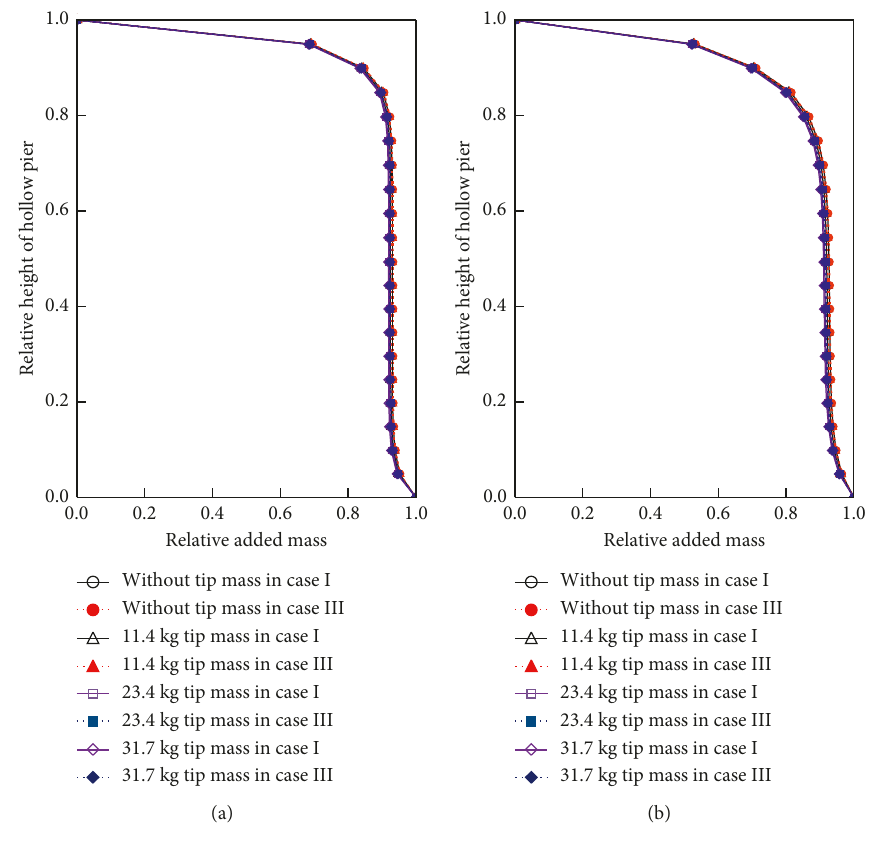
Figure 16: Comparison of the relative added mass distributions along the specimen corresponding to a water level of H (a) case III and case II along the x -axis; (b) case III and case II along the y